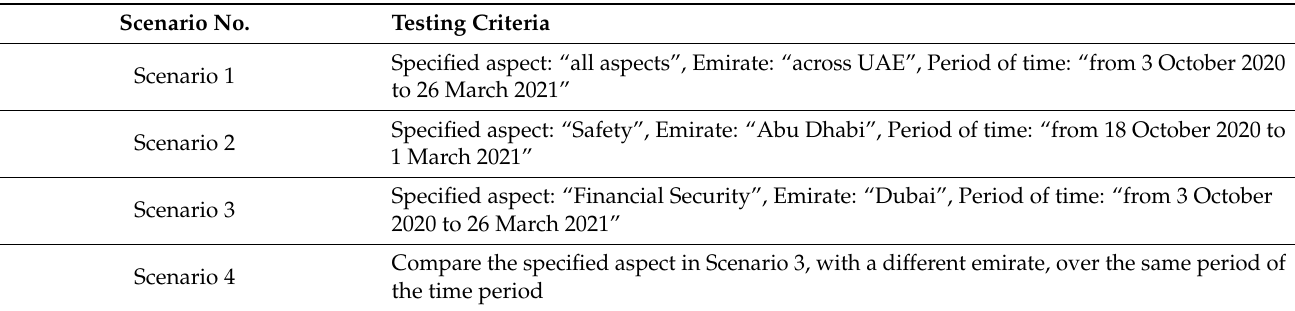
Table 13. Online testing scenarios to validate the functionality of the proposed framework for the defined